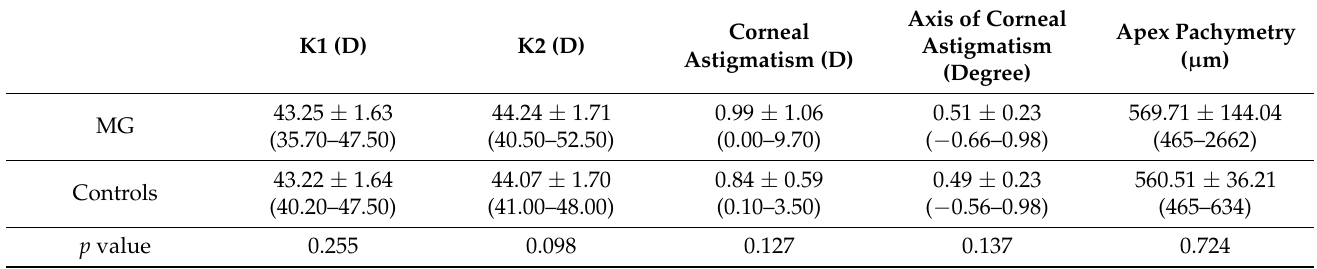
Table 2. Keratometric values and corneal astigmatism in Diopters (D), axis of astigmatism and apex pachymetry in subjects with monoclonal gammopathy (MG) and in controls, using Pentacam (Oculus, Wetzlar, Germany). p values show results of the statistical analysis using Mann–Whitney U